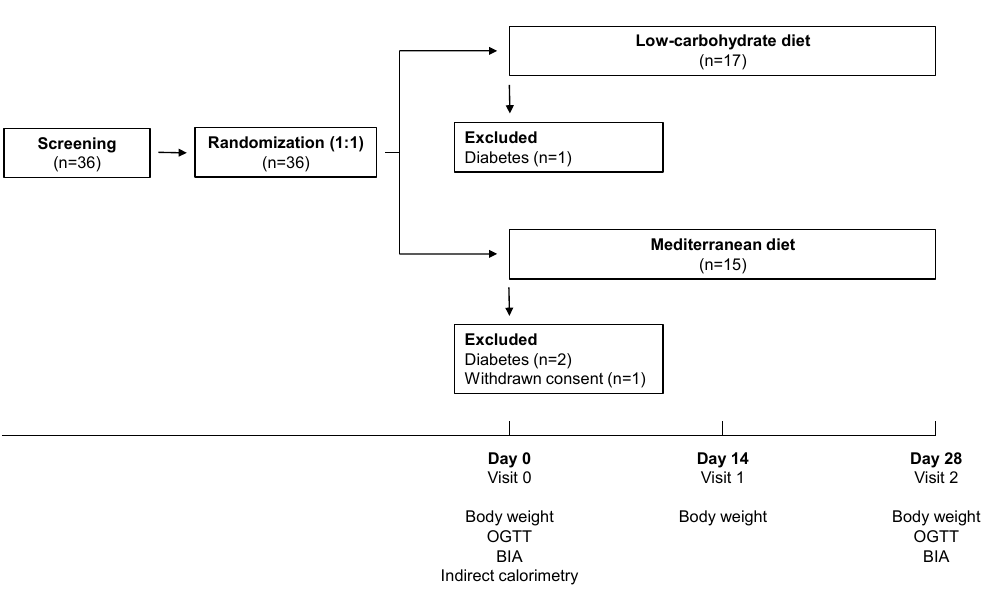
Figure 1. Study design. BIA, bioimpedance analysis; OGTT, oral glucose tolerance test.